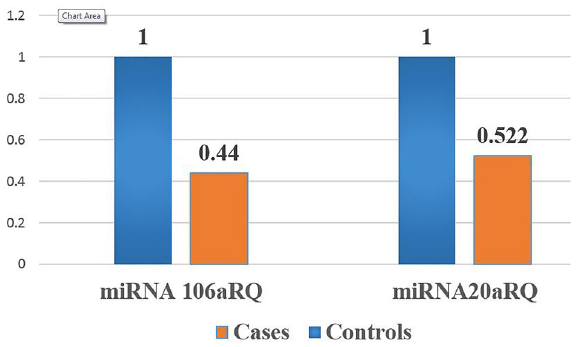
Figure 1. The relative expression levels of serum miRNA-106a and miRNA-20a in COVID-19 group and control group. Expression pattern of miRNA-106a and miRNA-20a in COVID-19 group compared to